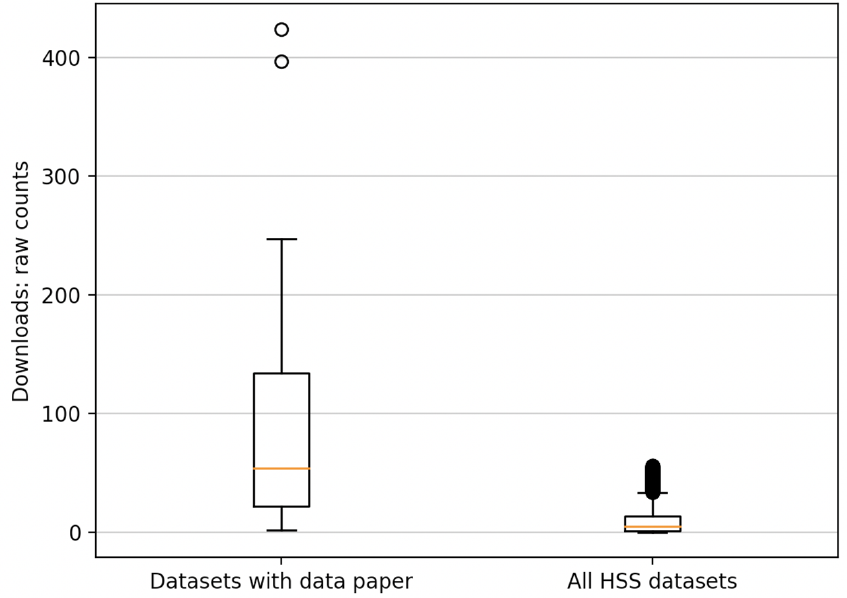
Figure 13. Comparison between datasets with an associated data paper and all HSS datasets (2015– 2022): downloads.